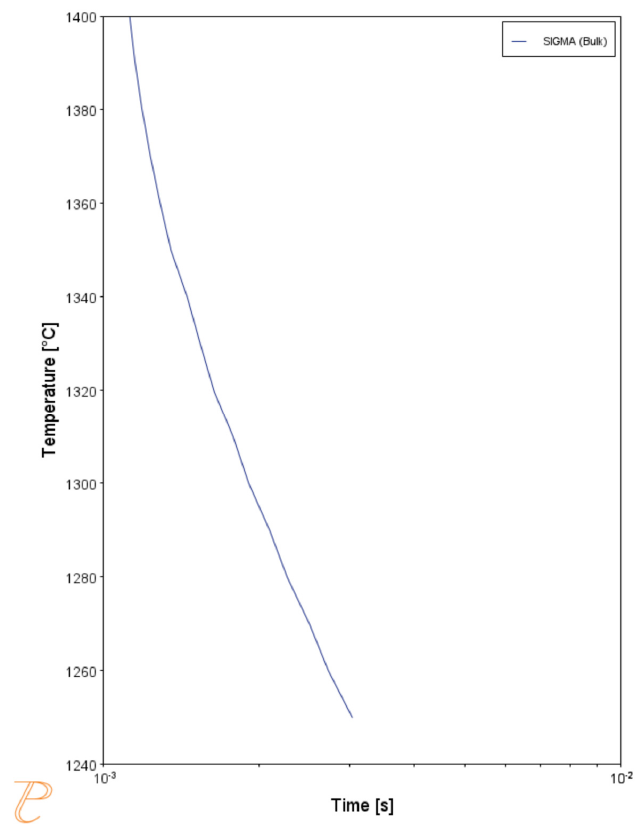
Figure 7. The time to the formation of a range of temperatures around the solution range of CMSX- 10N.